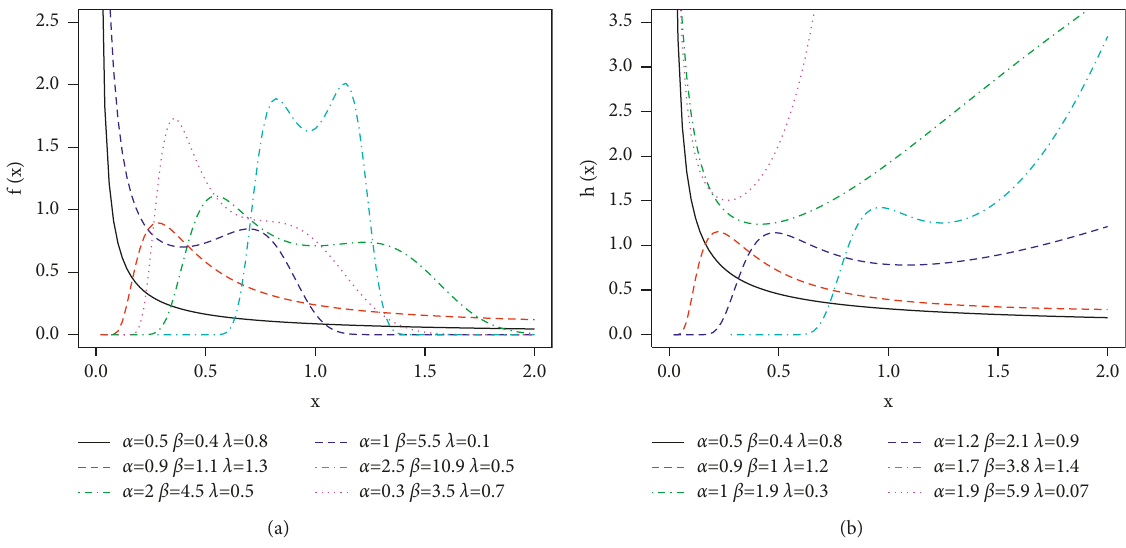
Figure 4: Graphical representation for the plots of the LCD: (a) density and (b) hazard rate using certain values of the